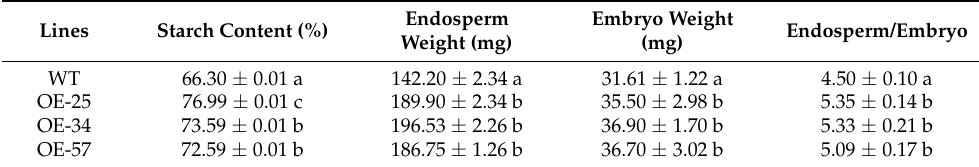
Table 2. Comparison of starch content and endosperm size of kernels of T 3 -generation GS5 trans- genic maize.